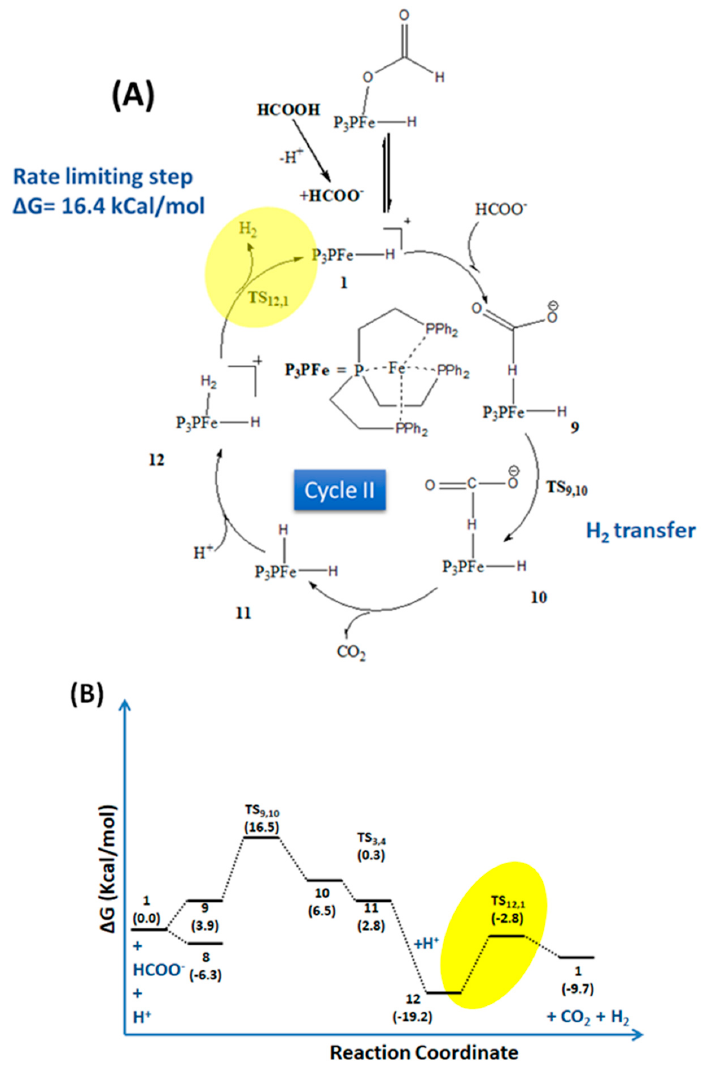
Figure 4. Catalytic Cycle-II for the [FePPh3 / HCOOH] system ( A ) and free energy profile ( B ). Figure Adapted from Reference [52]. In Cycle-II, the reaction is rate-limited by the transition state 12,1 regarding H-H release from the Fe-center.